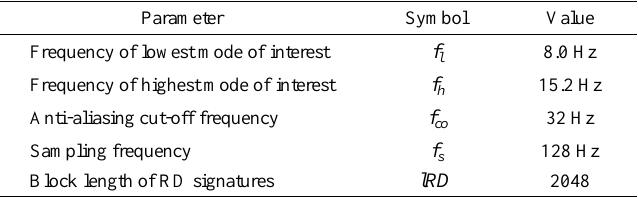
Setup of the monitoring system derived from the Experimental Modal Analysis Parameter Symbol Frequency of lowest mode of